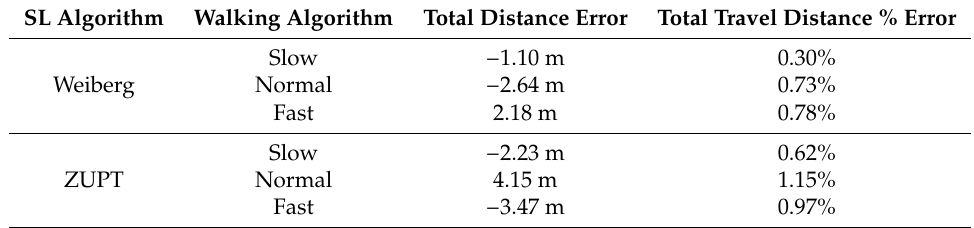
Table 4. Performance of two stride length estimation algorithms for 3 different walking speeds [24,25]. SL